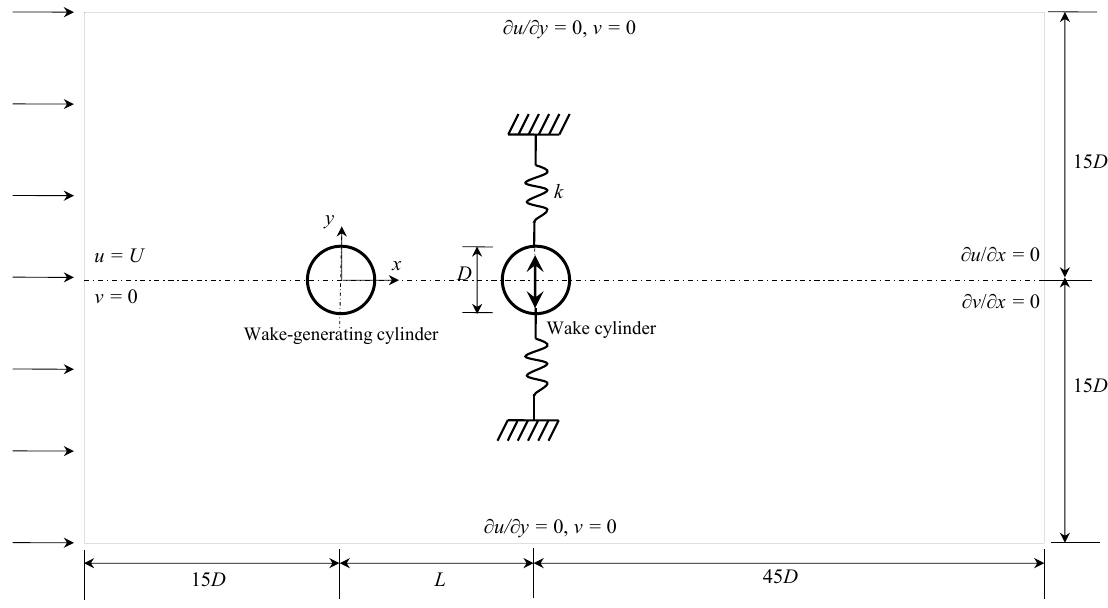
Figure 1. A schematic of cylinder configuration and computational domain.